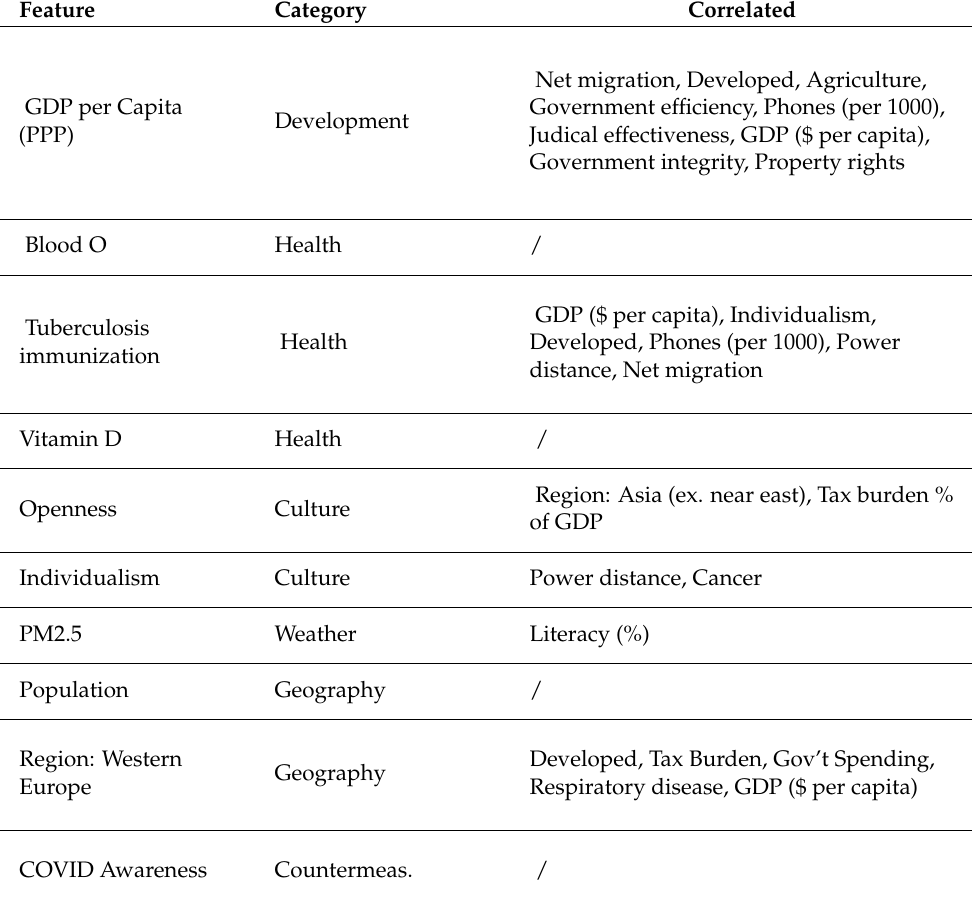
Table 14. Features selected using the Wrapper procedure for the Avg. daily infections class, alongside their category and the list of correlated